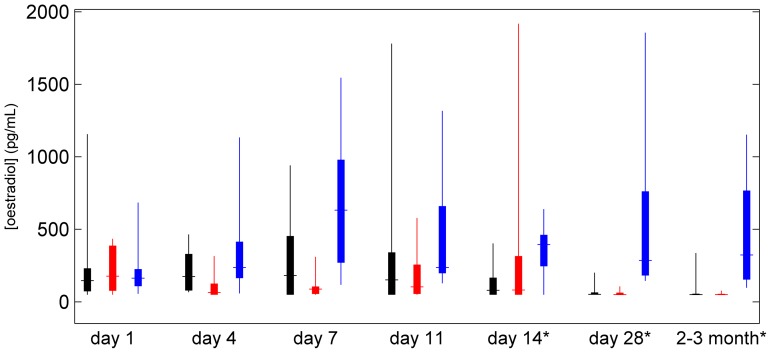
Box and whisker plot showing blood oestradiol concentration, with groups 1, 2 and 3 displayed in black, red and blue respectively. *indicates samples taken on MRI scan days.